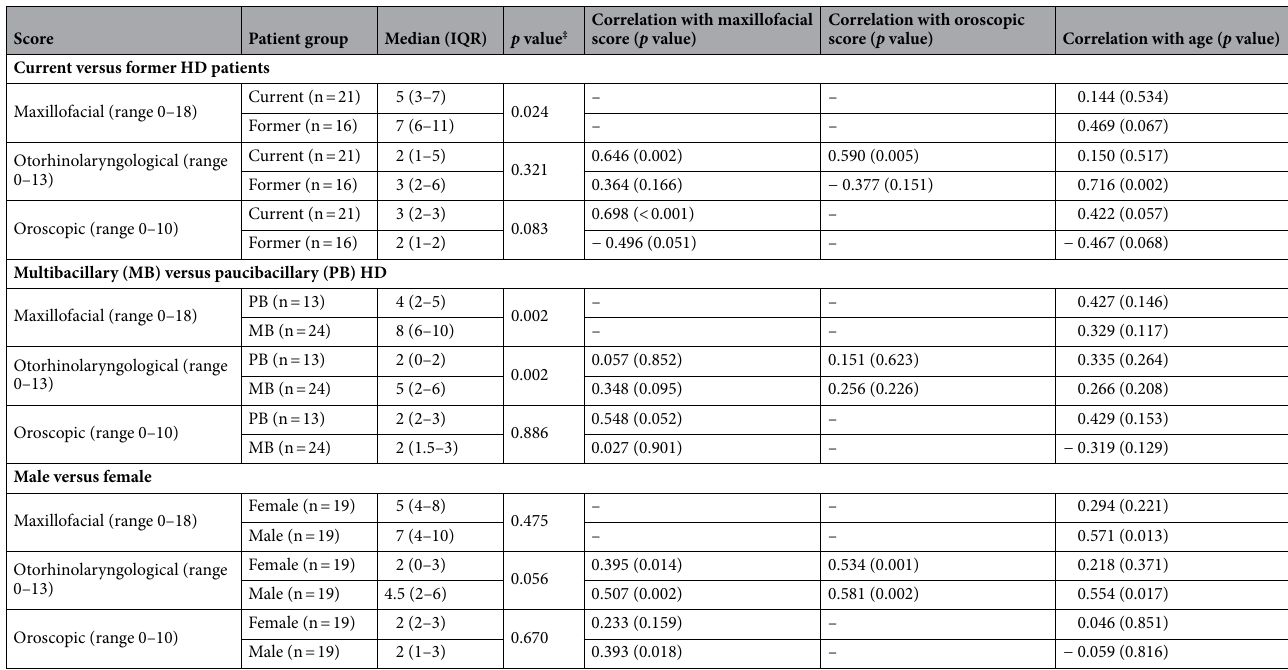
Table 4. Correlation between otorhinolaryngological and oroscopic findings and maxillofacial bone alterations in current and former HD patients. ‡ Kruskal–Wallis test comparing current versus former or MB versus PB or male versus female.